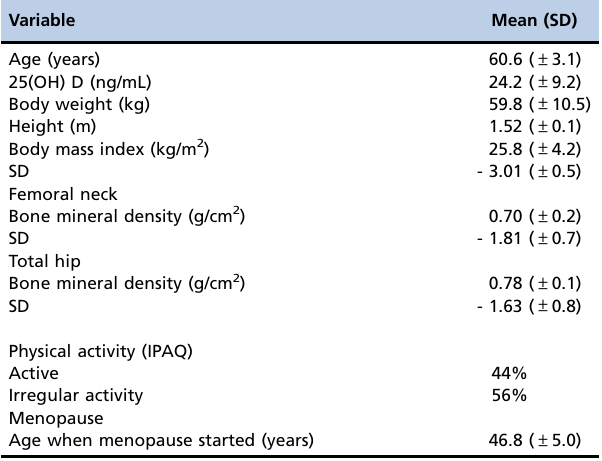
Table 1 - Baseline characteristics of the study participants.